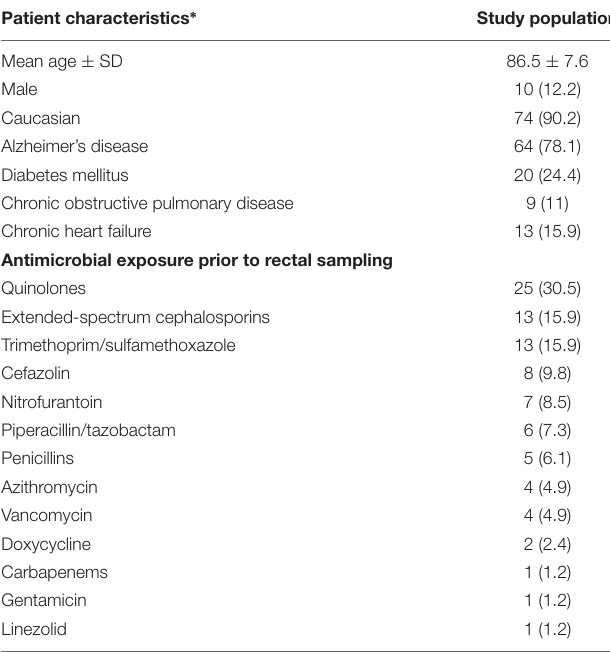
TABLE 1 | Characteristics and antimicrobial exposure of the study population of 82 elderly persons in nursing homes. Patient characteristics ∗